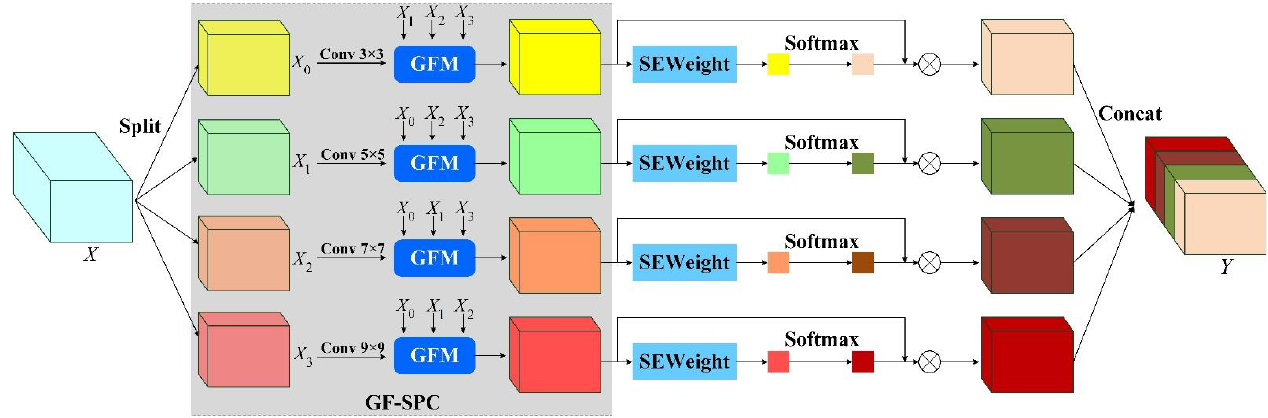
Figure 4. The structure of GF-PSA ( n = 4).